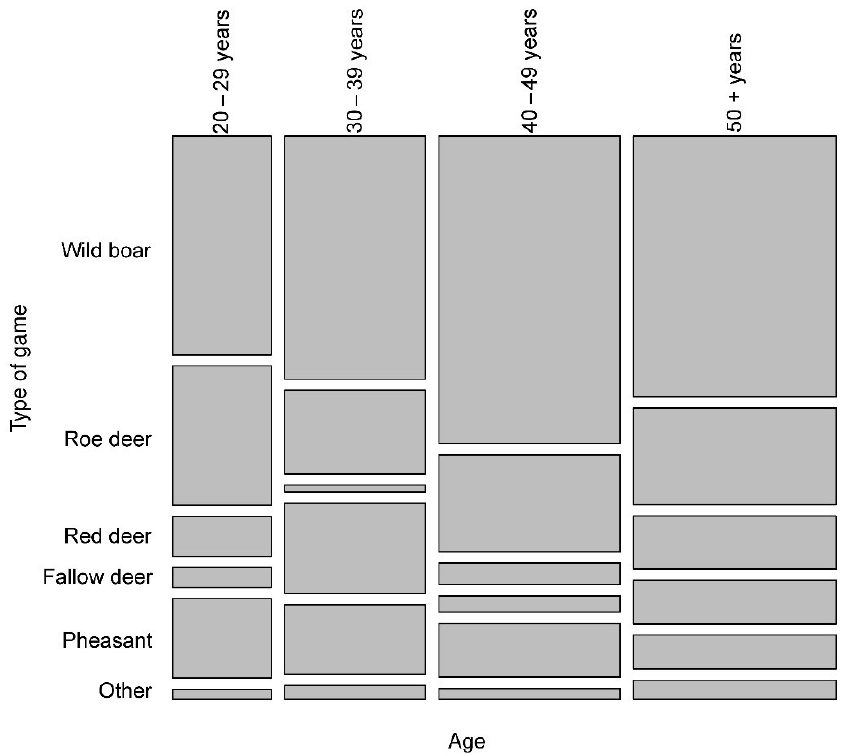
Figure 4. The mosaic displays the relationship between the respondent’s age and the type of game cooked at home ( n = 323).